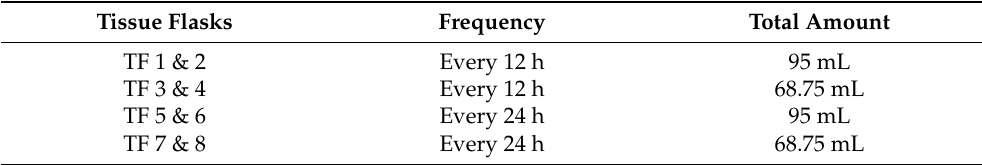
Table 2. Scheme of the frequency and amount of medium replacements of the different tissue flasks of the reference experiment. The total amount is the sum of the initial 25 mL and all replacements as described in Table